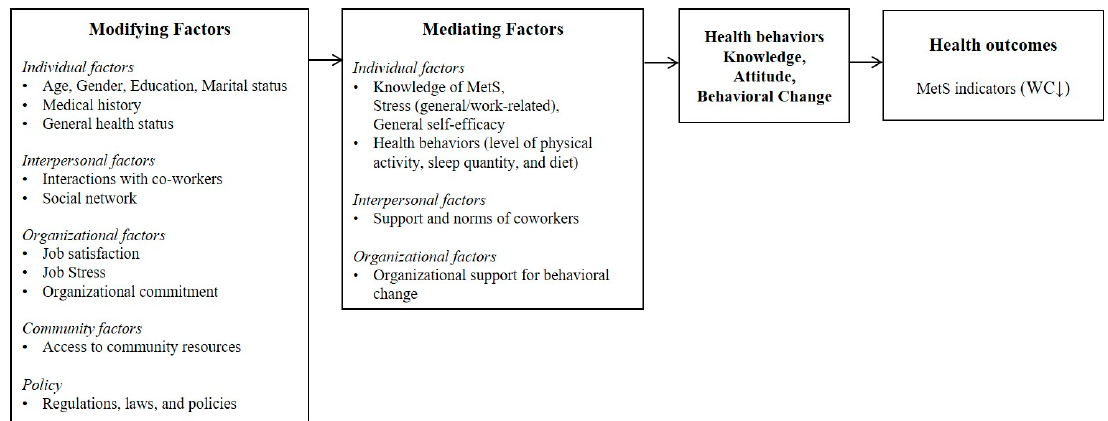
Figure 1. Intervention framework of the study.